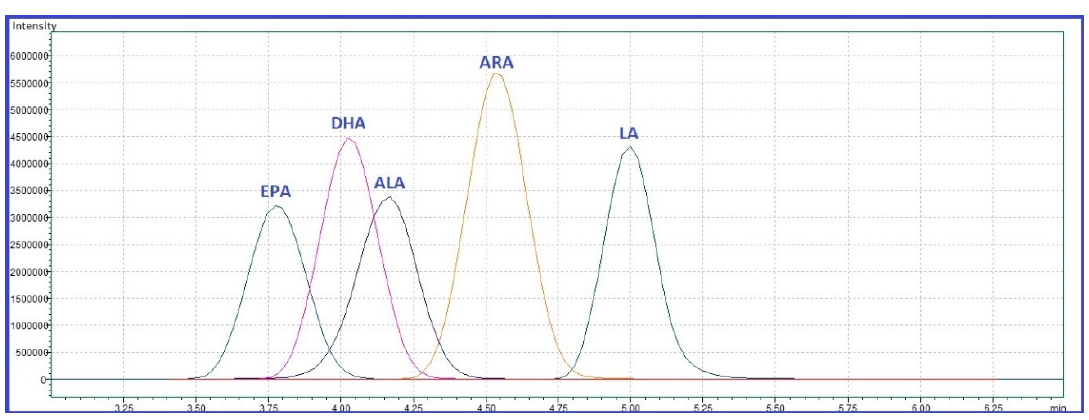
Figure 2. The overlaid total ion chromatograms of the targeted fatty acids. Data was obtained following analysis of a plasma sample (total FAs content). Legend: ALA— α -linolenic acid,